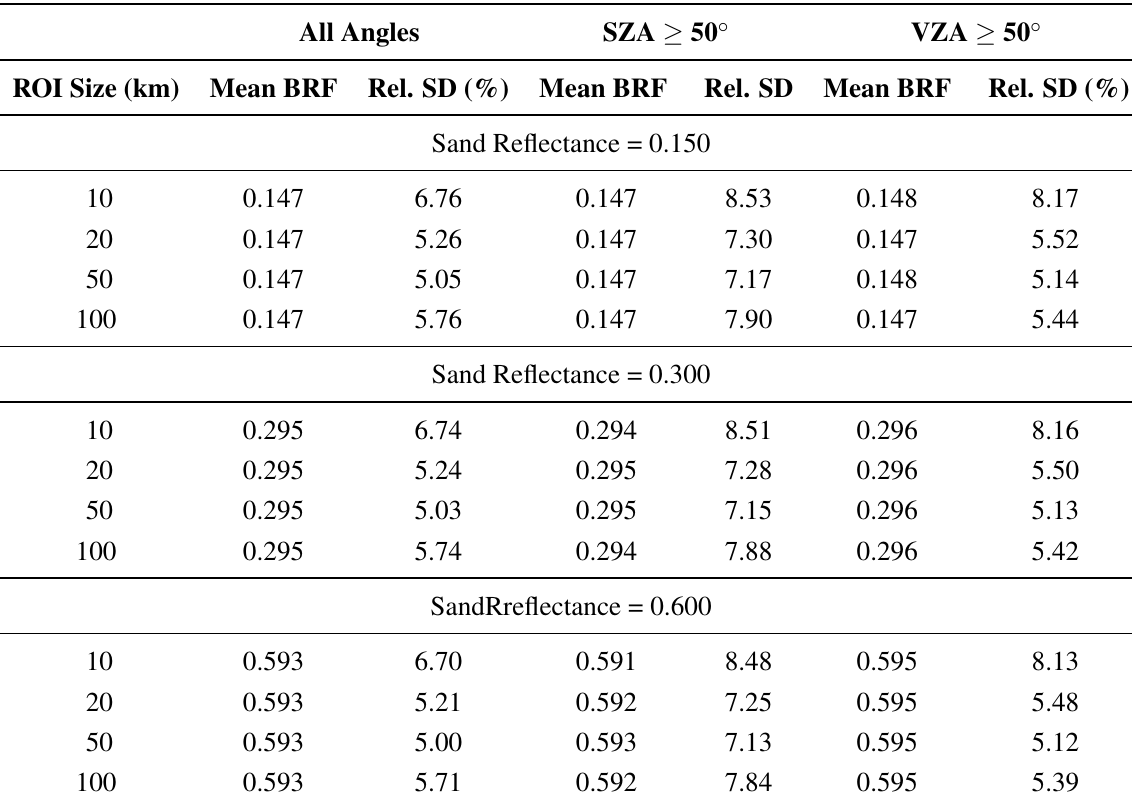
Table 2. Effect of Libya-4 ROI size on mean surface BRF and the relative standard deviation (SD). All Angles SZA ≥ 50 ◦ VZA ≥ 50 ◦ ROI Size (km) Mean BRF Rel. SD (%) Mean BRF Rel.